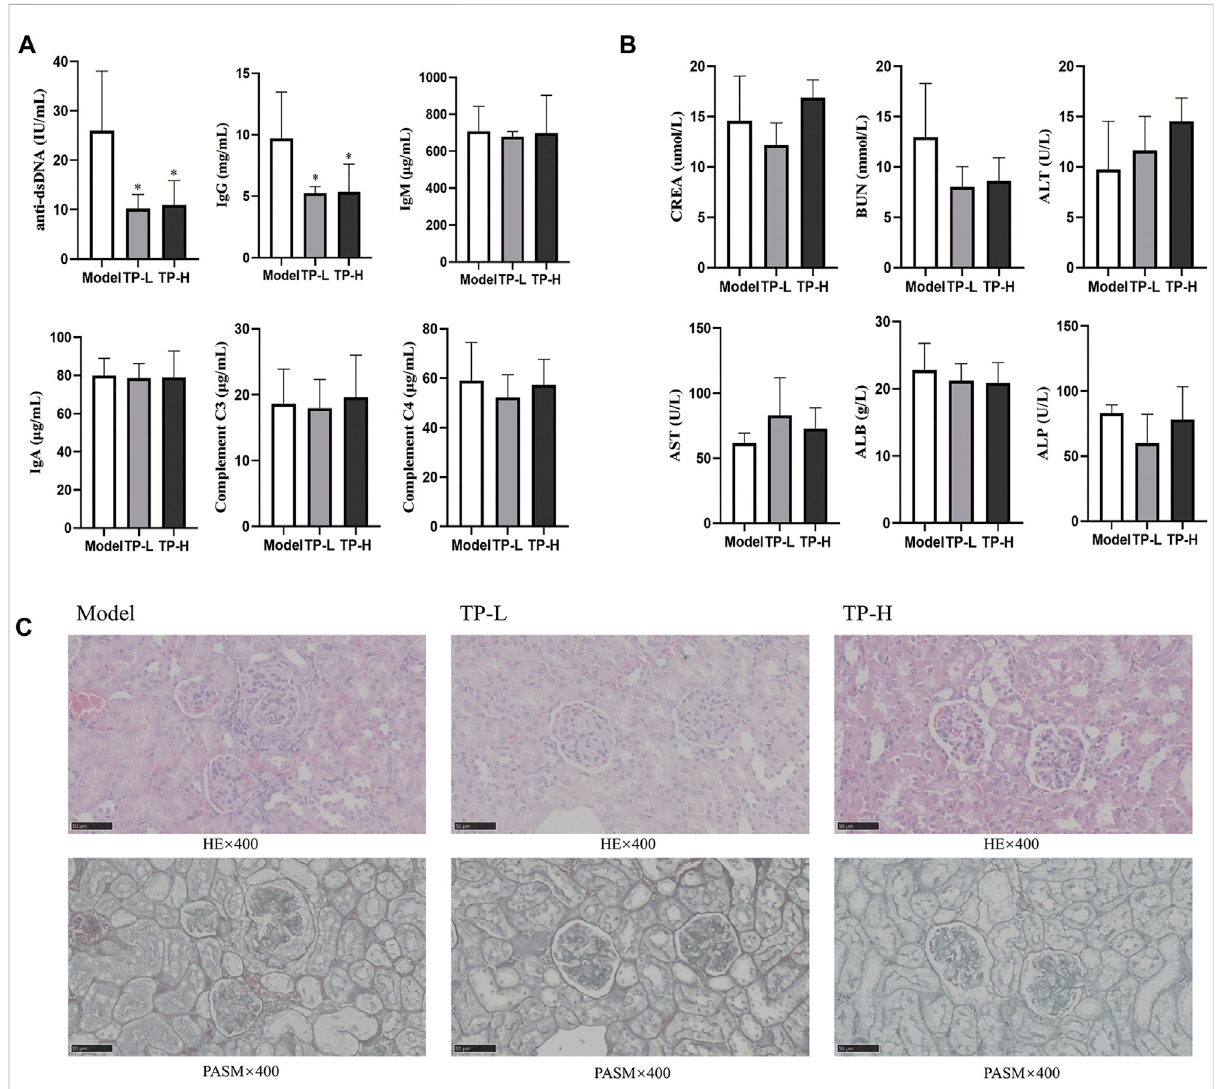
FIGURE 1 TP alleviates the disease condition in MRL/lpr mice. (A) Immune-related indexes in MRL/lpr mice. (B) Liver and kidney function indexes in MRL/ lpr mice. (C) HE and PASM staining of the kidneys from MRL/lpr mice (Magni fi cation ×400; Scale bar = 50 μ m). ( n = 5, * p < 0.05, ** p < 0.01, *** p <